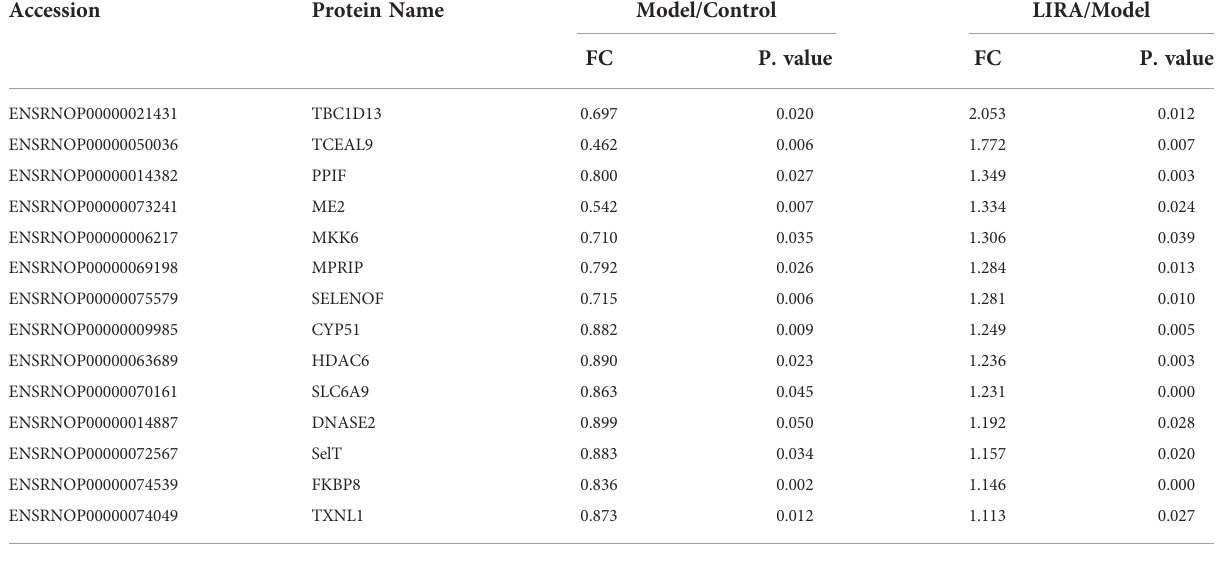
TABLE 2 Up-regulated pancreatic DEPs in LIRA compared with Model rats (n=3).